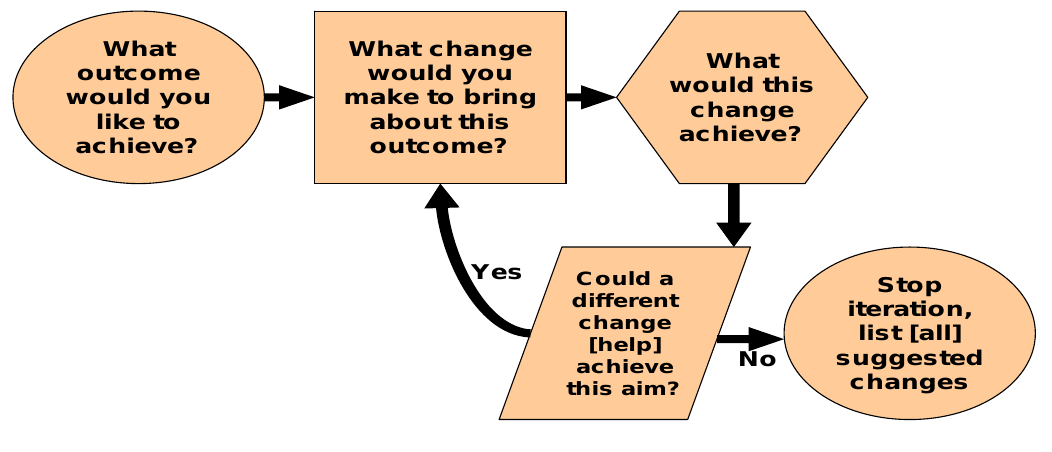
Figure 15. Systematic exploration of problems and solutions Source: Cinderby and Forrester (2008), Figure